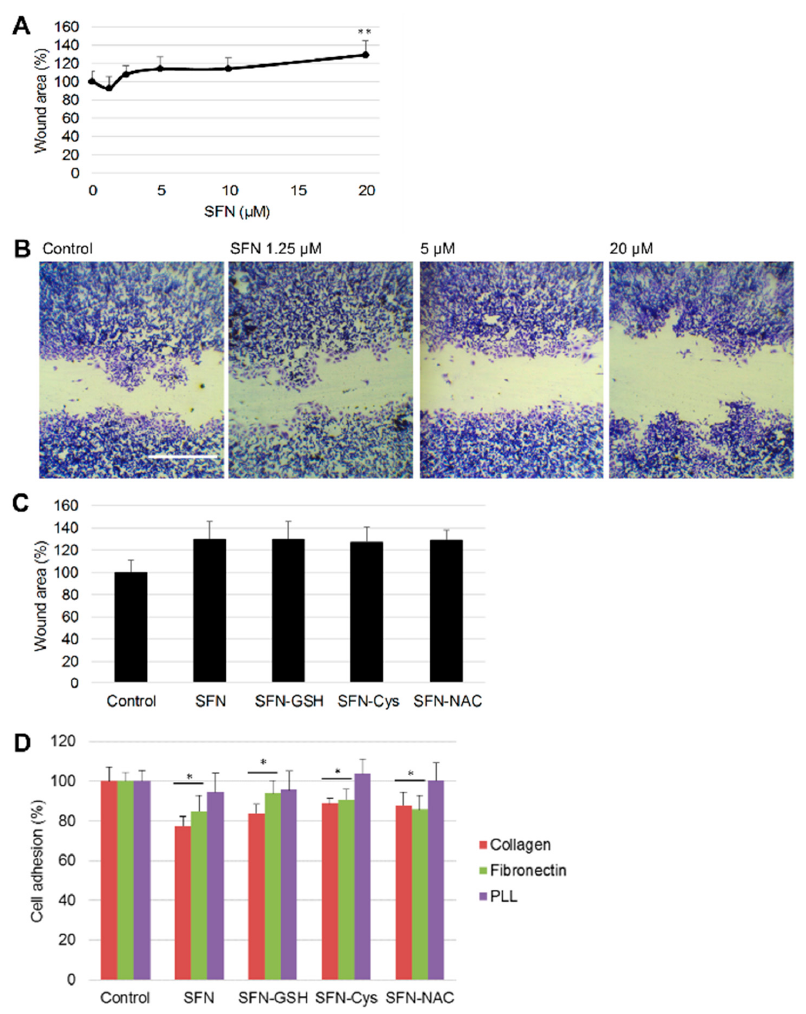
Figure 3. Effect of SFN and its metabolites on HepG2 cell migration and adhesion. ( A ) Cells